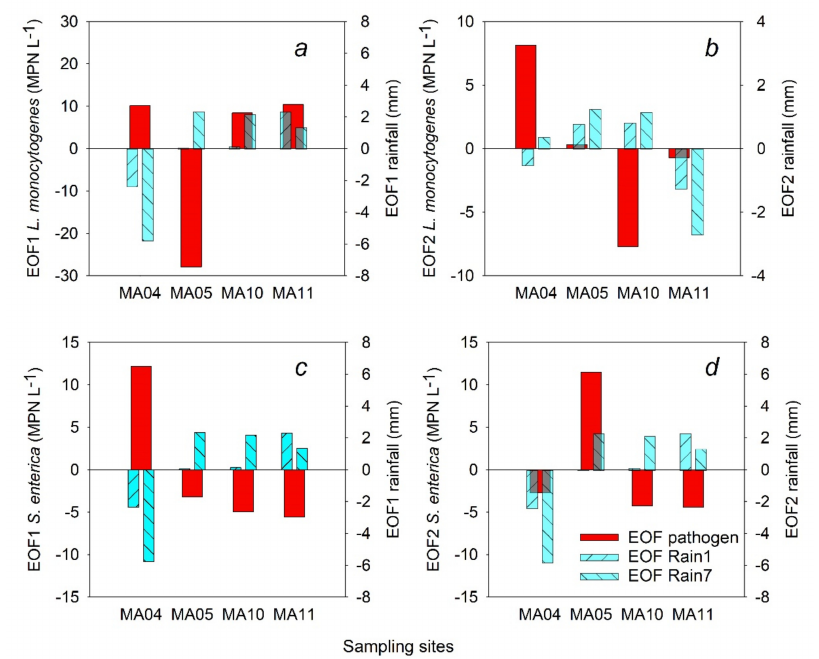
Figure 2. First (EOF1) and second (EOF2) spatial patterns of L. monocytogenes and Salmonella and cumulative rain fall over one (Rain1) and seven (Rain 7) days before sampling; ( a ) L. monocytogenes EOF1; ( b ) L. monocytogenes EOF2; ( c ) Salmonella EOF 1; ( d ) Salmonella EOF2. Solid (red) lines indicate EOF values of the pathogens; striped (turquoise) lines indicate EOF values of Rain1 (diagonal to the left) or Rain7 (diagonal to the